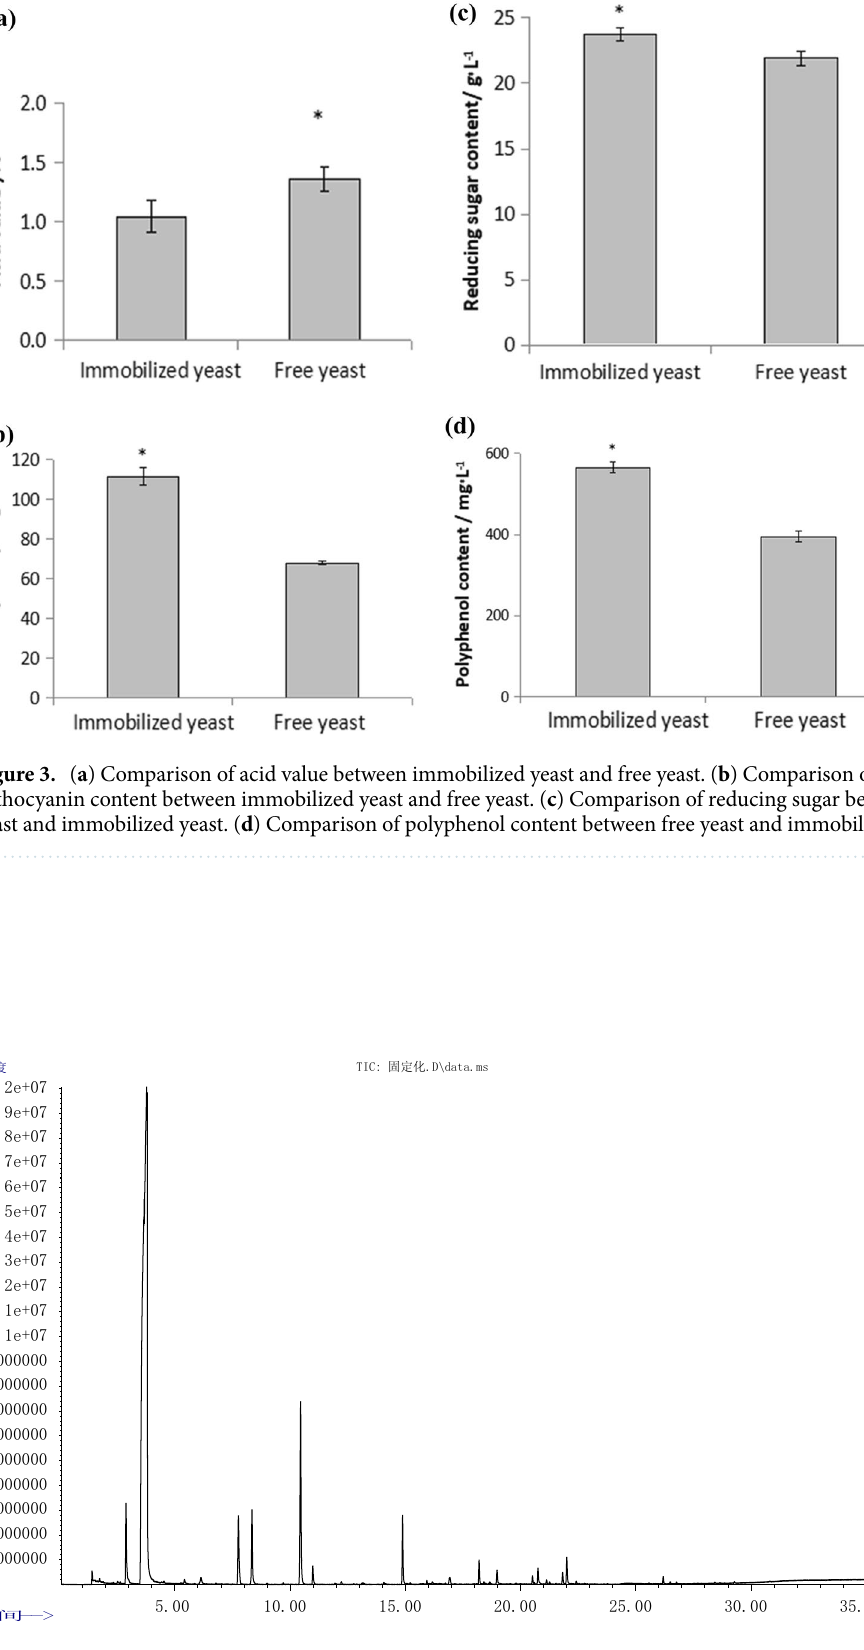
Figure 4. GC–MS total ion outflow Figure of aroma components of red raspberry wine fermented with Immobilized